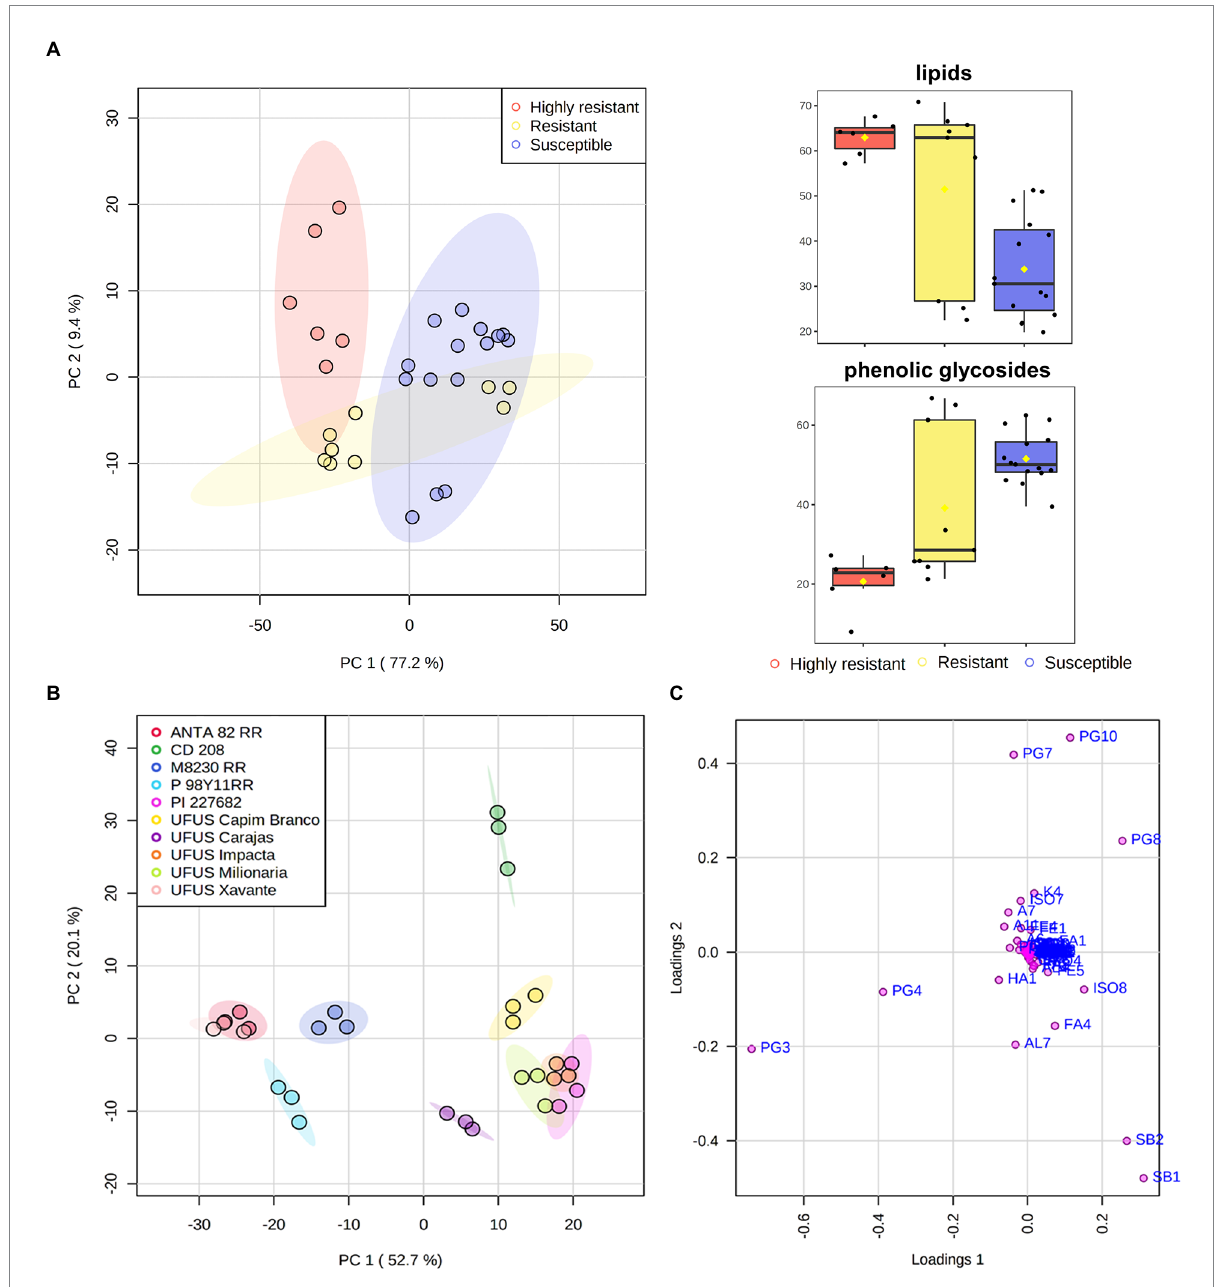
FIGURE 2 First and second component scores (A, B) and loadings (C) from samples and variables. These are arranged according to the influence of relative areas from nonvolatile and volatile compound chromatographic signals found in leaves of Glycine max (codes of the variables listed in Table s 2, 3). The color shaded area in each cluster represents the 95% confidence region. Box-and-whisker plots of lipids and phenolic glycosides relative area detected in G. max leaves. Y-axis represents the normalized sum of chromatographic peak